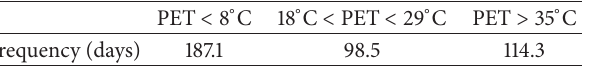
Table 2: Mean frequency (days) of characteristic thresholds of PET, within the period 1999–2007.